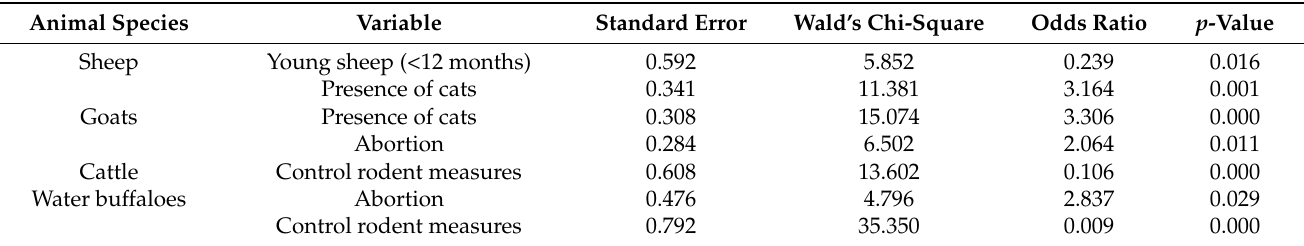
Table 3. Results of the multivariate logistic regression analysis. Variables associated with seropositivity to T. gondii , according to the animal species.